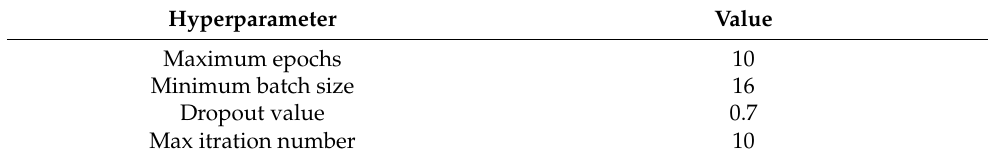
Table 3. Hyperparameter setting based on Bayes-Bi-LSTM algorithm.